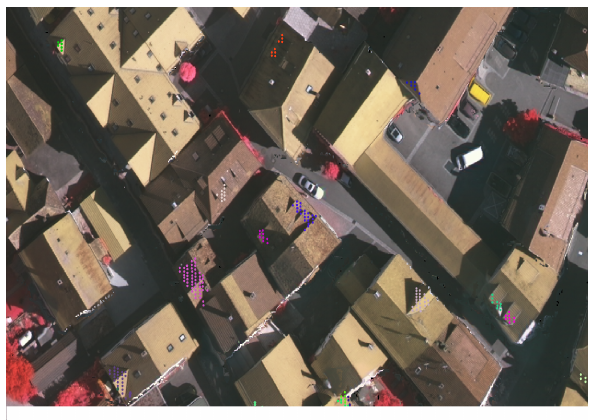
Figure 7. Two dormers considered as a single component due to their